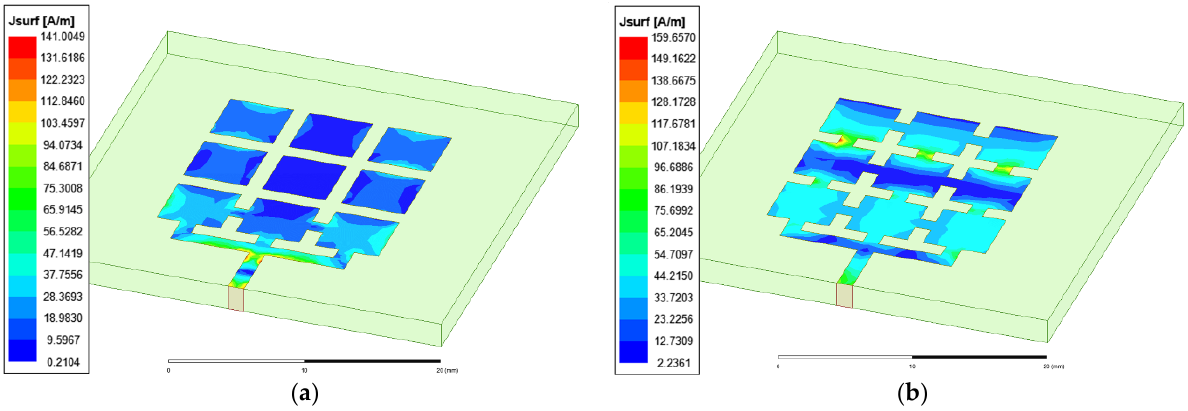
Figure 5. ( a ) Mode 1 antenna surface current distribution; ( b ) Mode 2 antenna surface current distribution.